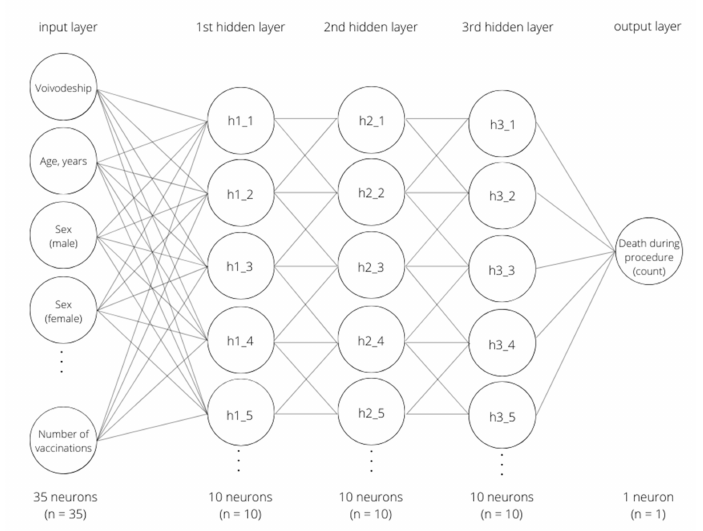
Figure 1. Model of the neural network used in the study. This model is a deep artificial neural network (DNN) with architecture, consisting of 35 input neurons (for one variable each), 3 hidden layers with 10 neurons each (for feature extraction from data), and 1 output neuron (for the prediction of the count of patient deaths during the procedures).